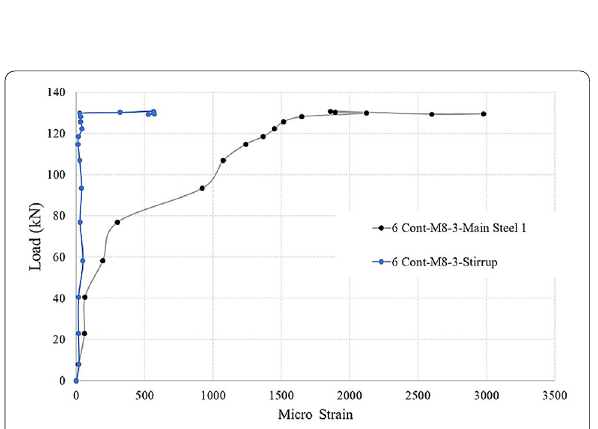
Fig. 7 Load-Strain curve for 6Cont-M8-3